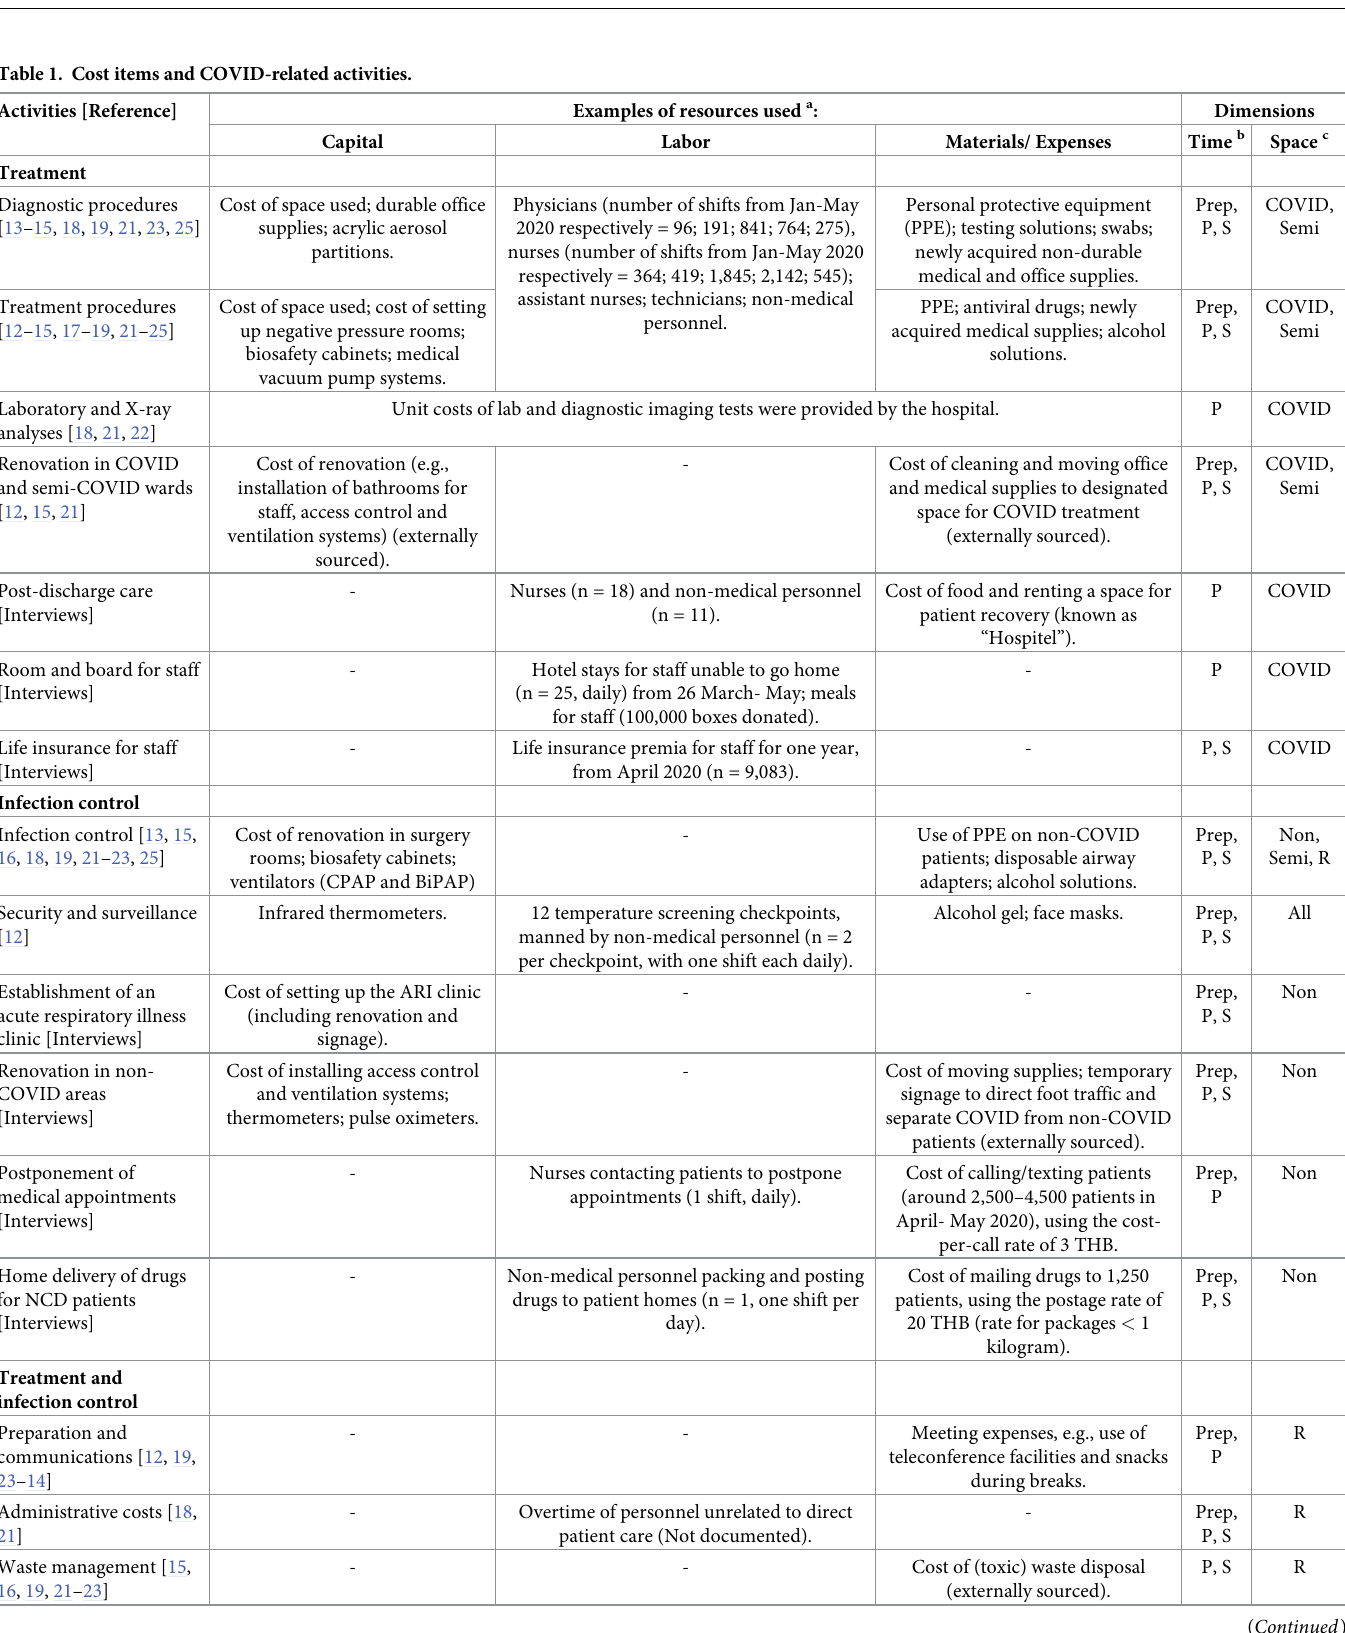
Table 1. Cost items and COVID-related